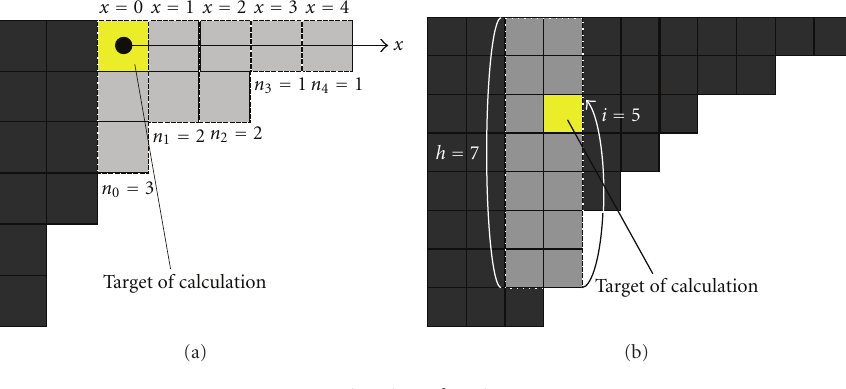
Figure 14: Estimation of strain gauge